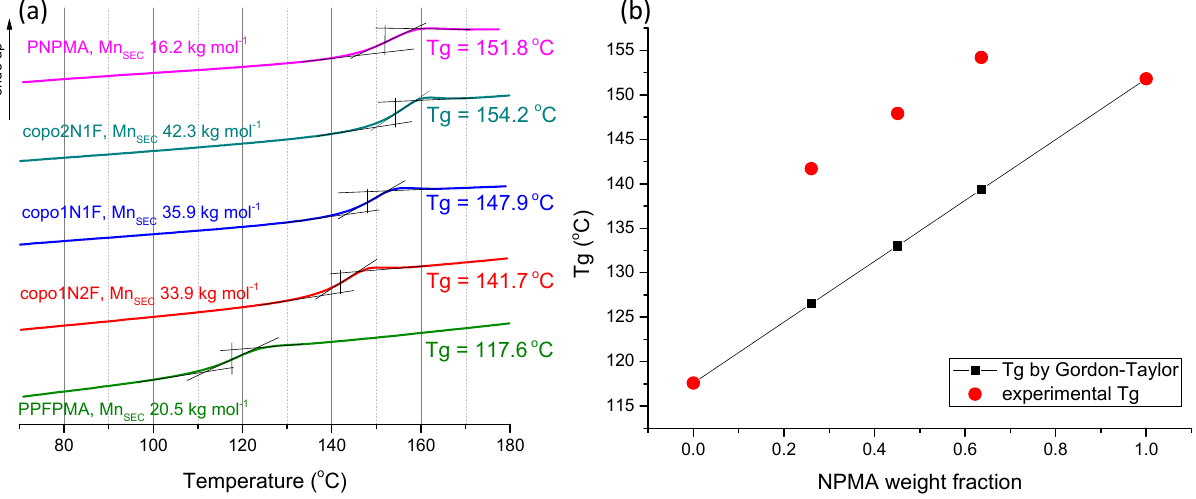
Figure 5. ( a ) DSC profiles of PPFPMA, PNPMA, and copolymers at different compositions after 68 h of polymerization; ( b ) dependence of experimental Tg ( • ) on weight fraction of NPMA moieties compared to expected Tg of copolymers calculated by Fox–Flory equation ( (cid:4) ).